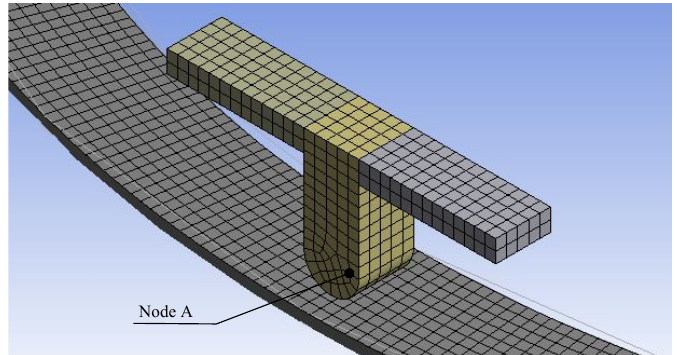
Figure 6. Meshed system.